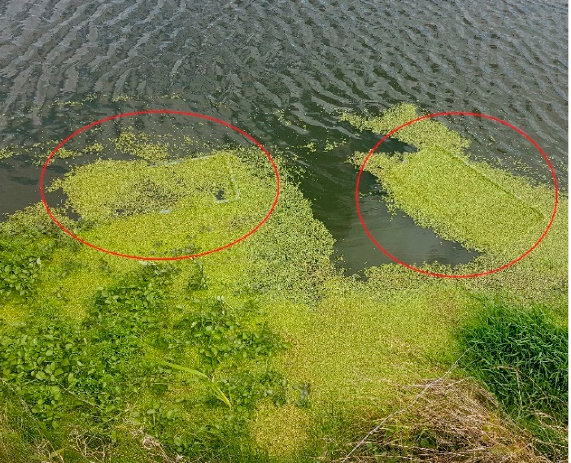
Figure 1. Tanks (circled in red) were submerged for a week in one of the duckweed ‐ covered canals prior to being used for the mesocosm experiment. The pre ‐ treatment resulted in the establishment of a biofilm on the internal surface of the tanks.